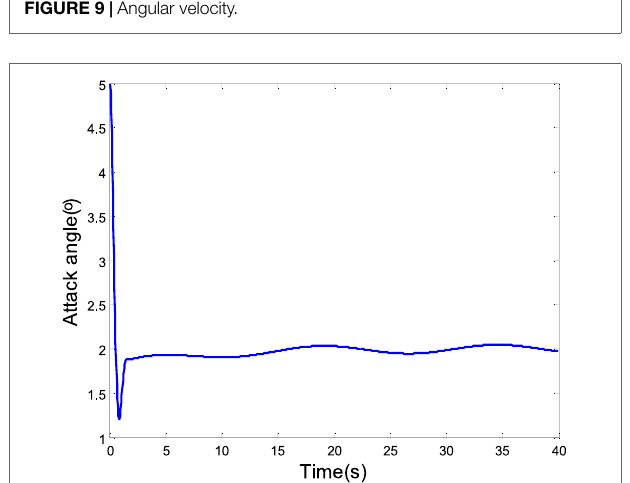
FIGURE 9 | Angular velocity.